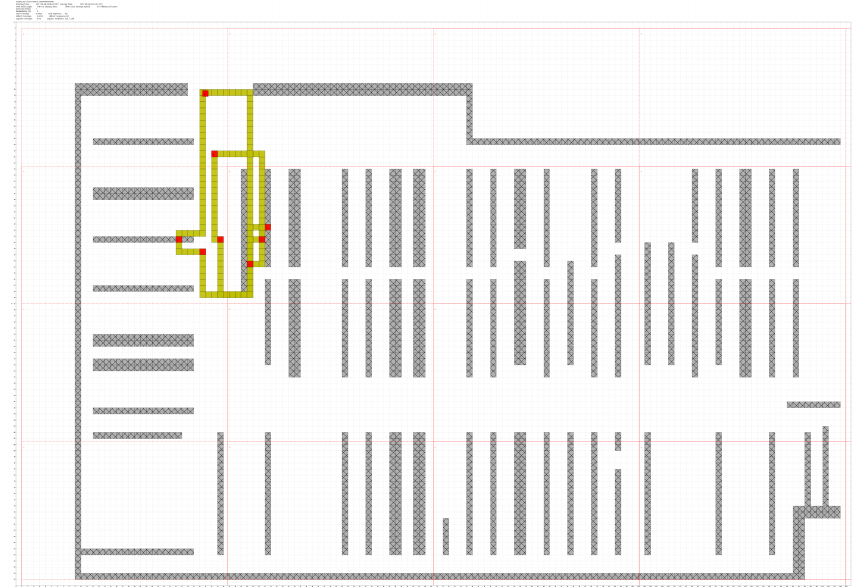
Figure 4. A short trajectory.